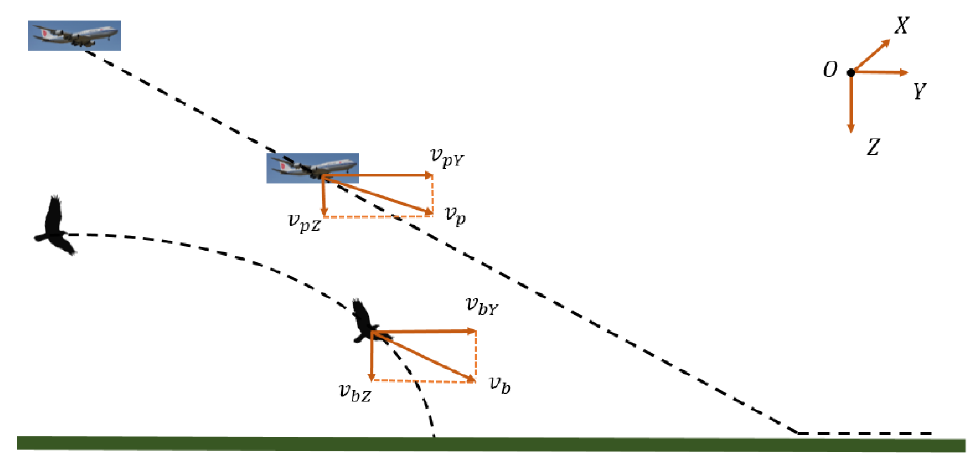
Figure 1. The landing trajectories of a bird and fixed-wing aircraft.